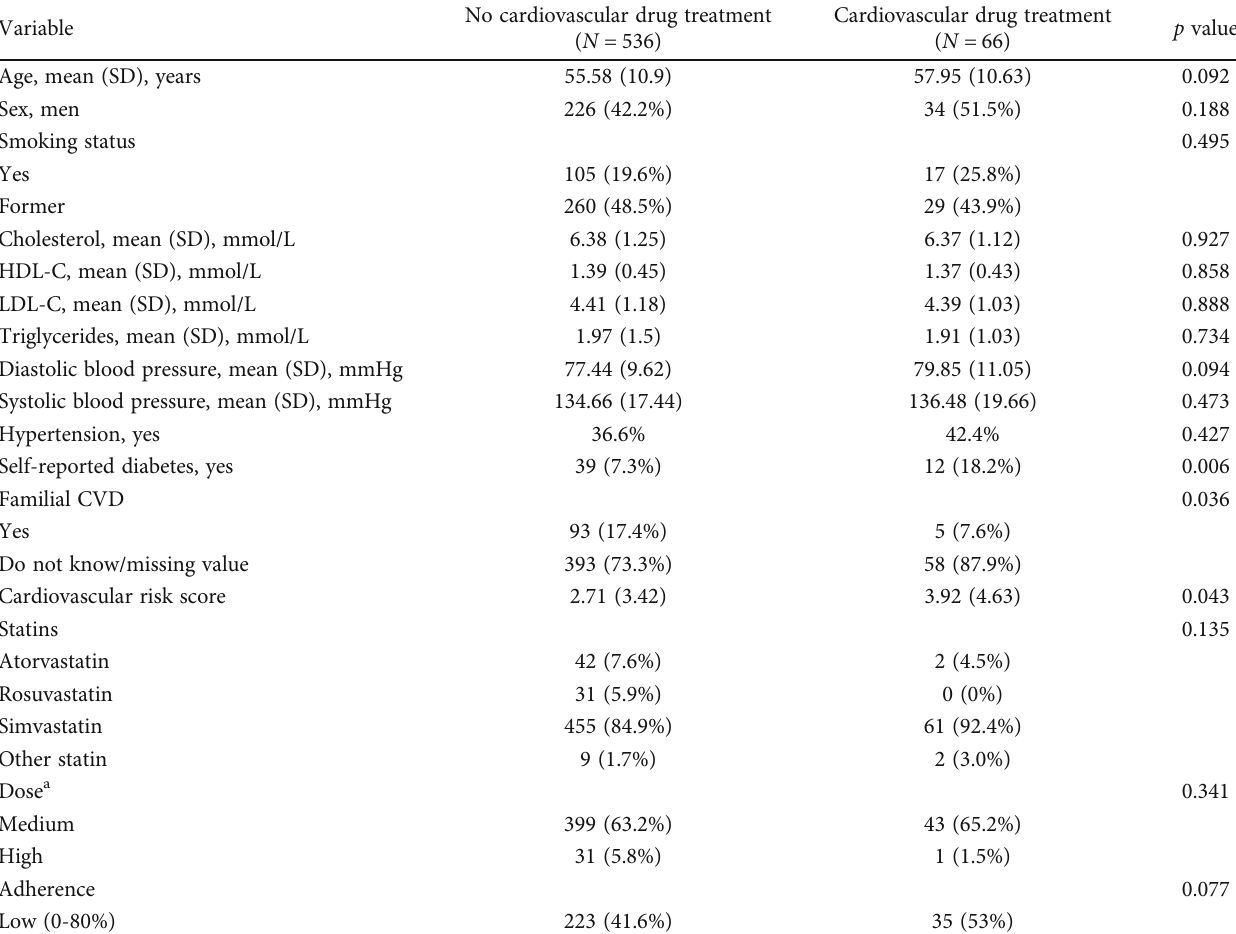
Table 2: Baseline characteristics of participants with and without cardiovascular drug treatment.